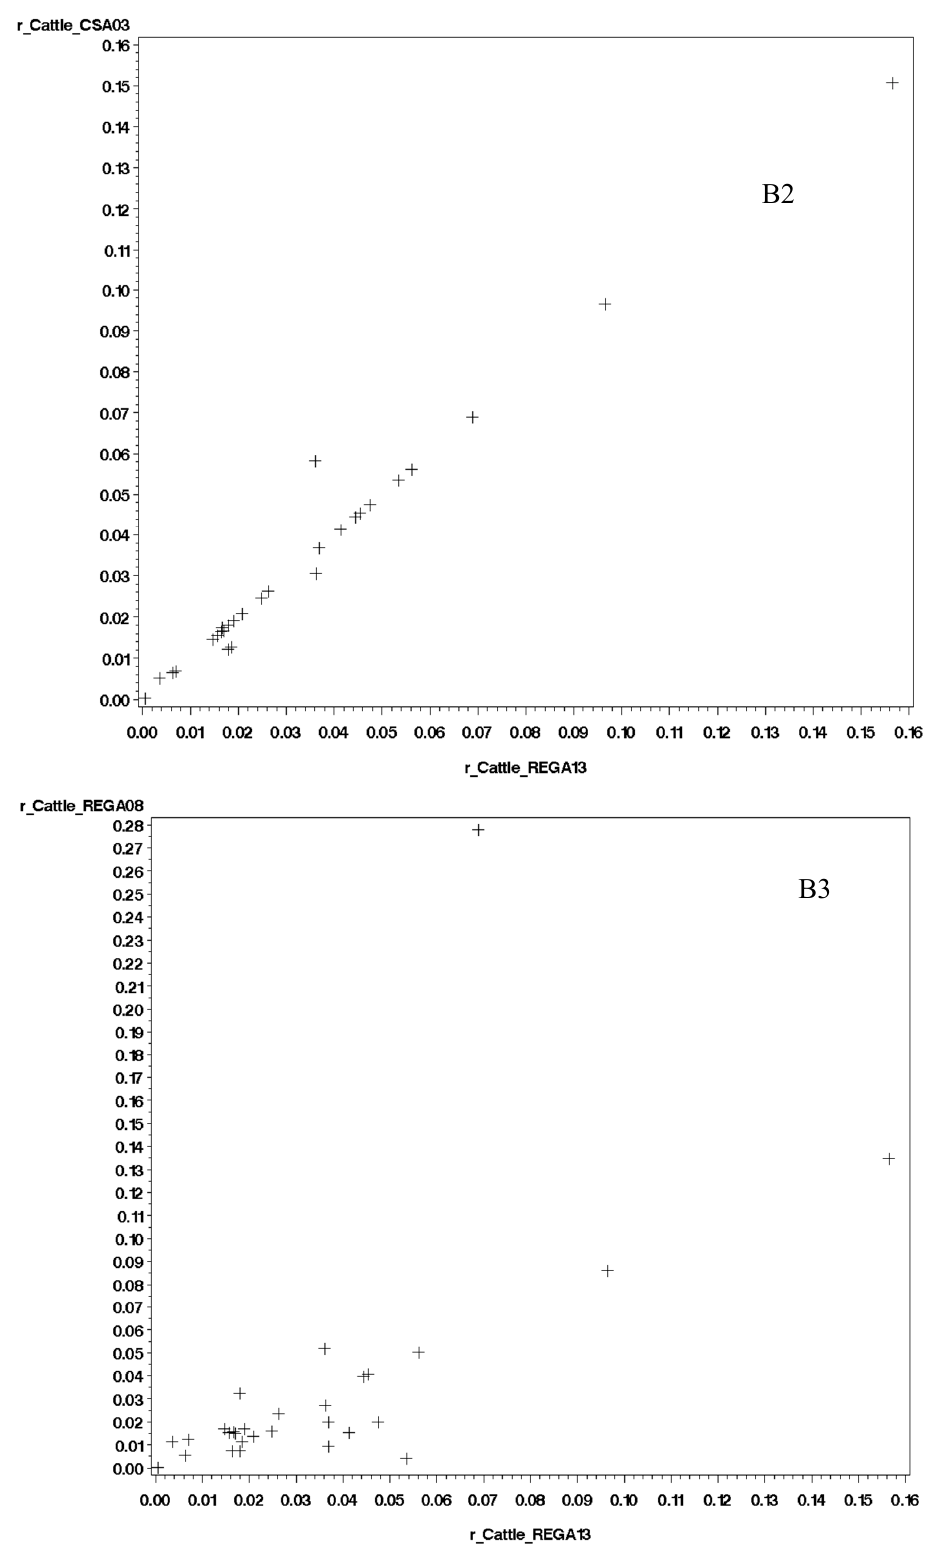
Figure A2. Scatter plots of relative number of heads for cattle (B1–B3).